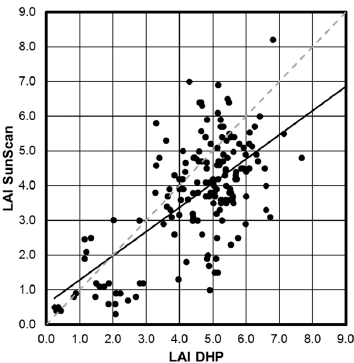
Figure 4. Relationship between leaf area index values extracted from digital hemispherical photogra- phy using CanEye software (x-axis) and measured by SunScan device (y-axis). Transformed SunScan LAI values were merged with the DHP-based LAI estimations to produce a harmonized dataset of in situ LAI measurements for validating the Sentinel- 2 based LAI product (see Section 3.3).